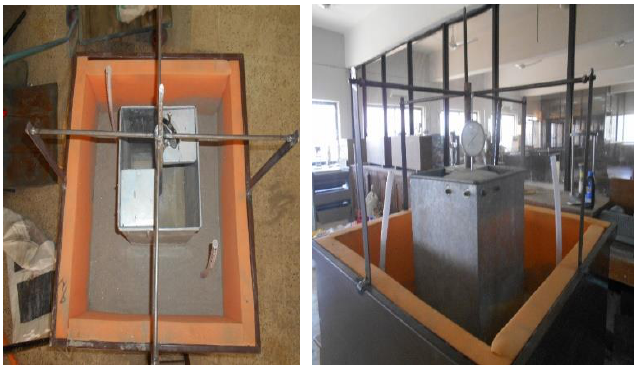
Fig. 3. Installed